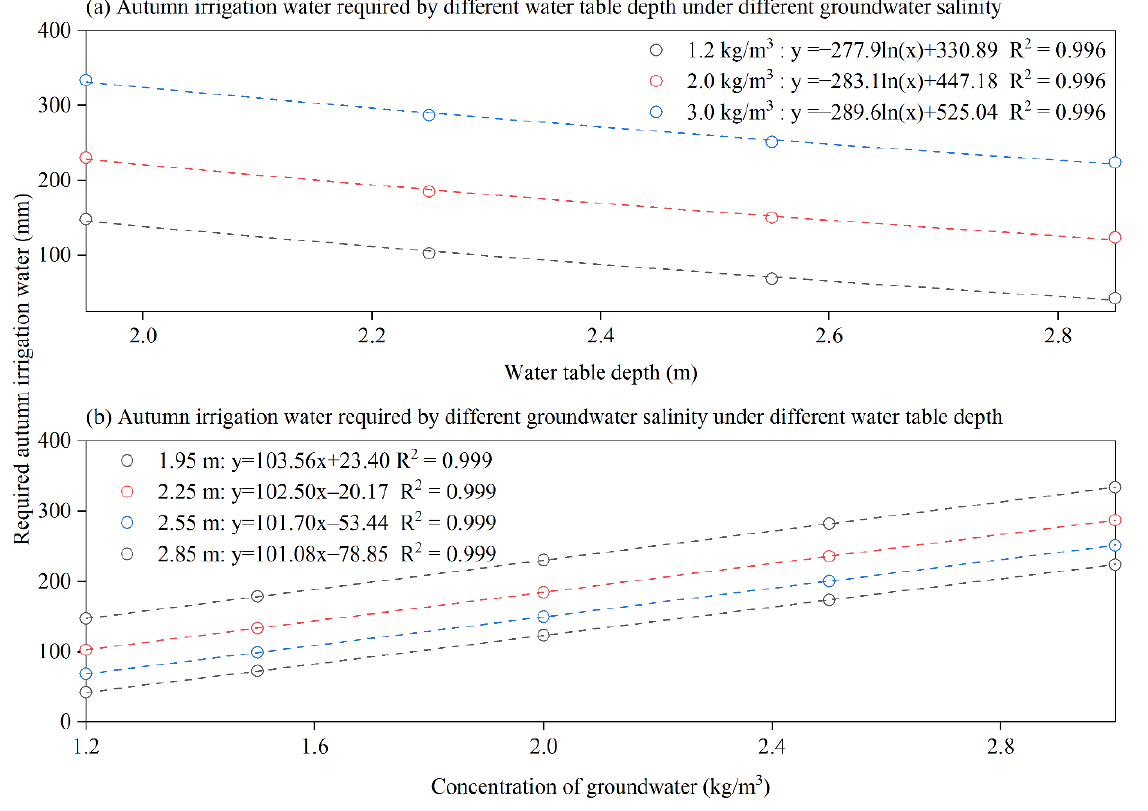
Figure 12. The relationship between water table depths and the required autumn irrigation water to sustain root zone within a mild salinity level in the canal irrigation area.